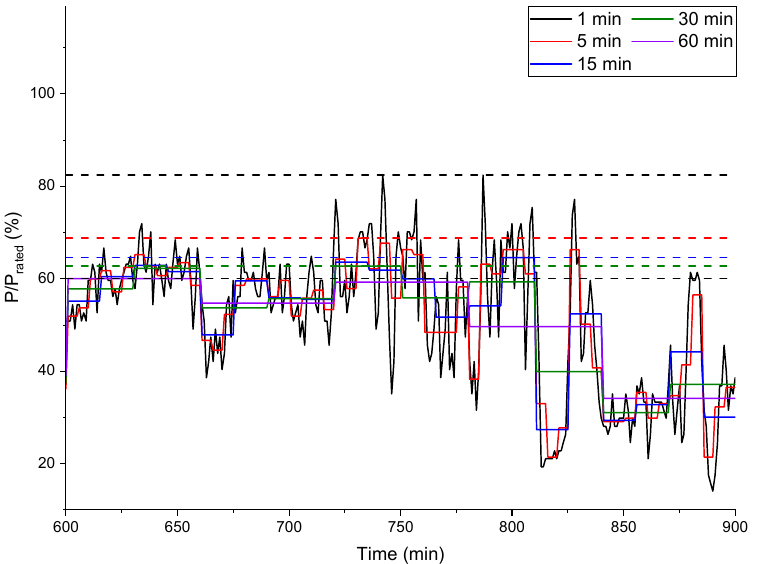
Figure 1. Comparison of power output fluctuations with control periods of 1, 5, 15, 30, and 60 min.